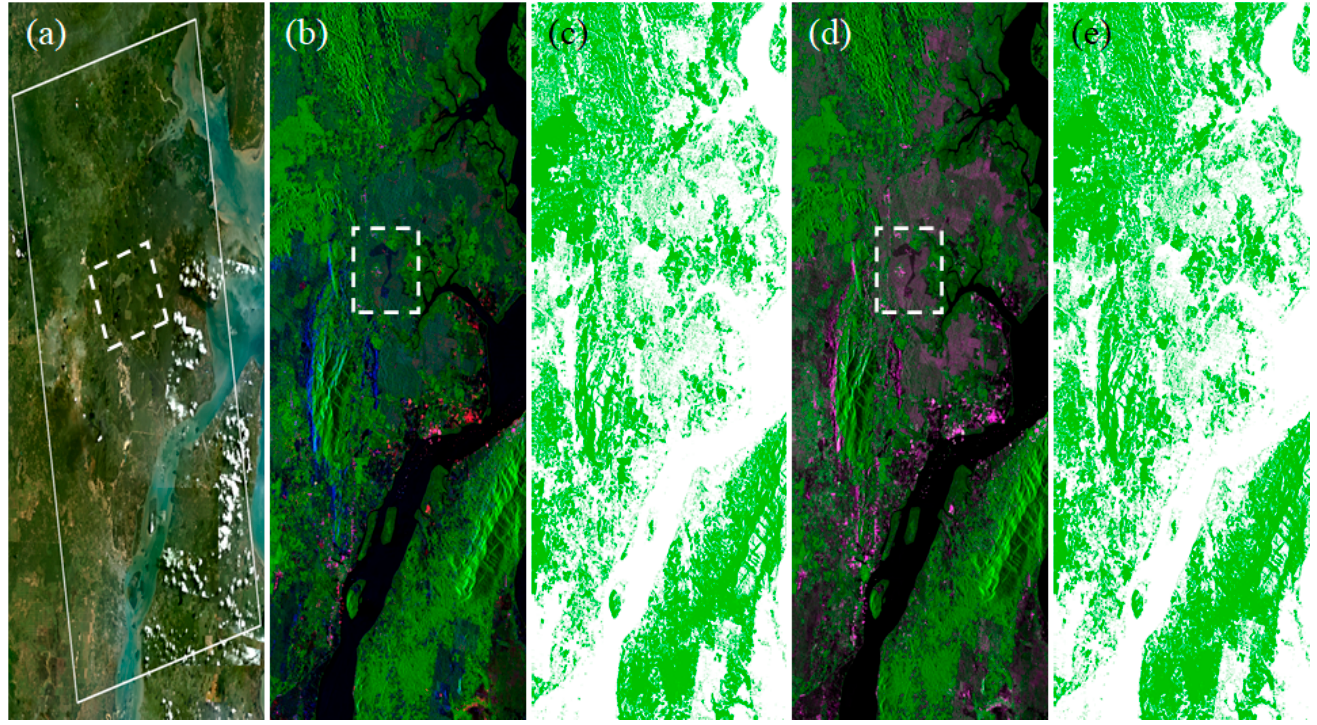
Figure 4. Forest maps of Kalimantan in Indonesia using the proposed method and 6SD method with the POLSAR data acquired on 29 October 2016 and a window size of 10 × 20 pixels. ( a ) Mosaic image acquired by Planet/Dove from June to November 2016. The white rectangle shows the observation area of PALSAR-2. ( b – e ) Same as in Figure 3. The white dotted rectangle shows the oil palm plantation.